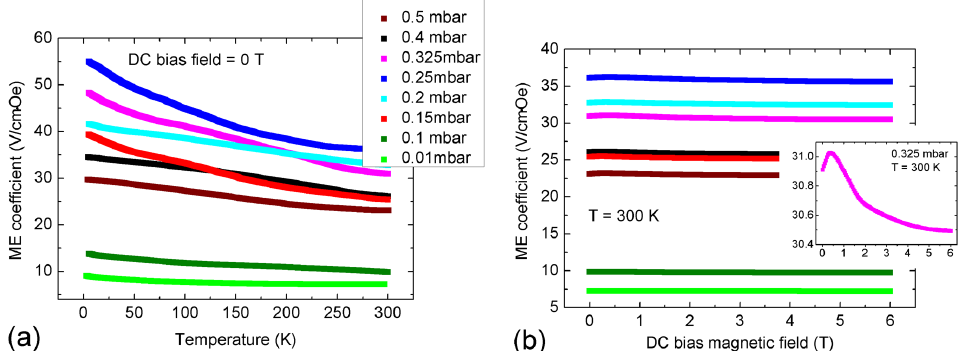
Figure 7. Magnetoelectric voltage coefficient α ME of BaTiO 3 ‐ BiFeO 3 composite thin films in dependence of ( a ) temperature and ( b ) the DC bias magnetic field, for the indicated oxygen partial pressures during the growth of the composites. The legend of ( a ) is valid for both ( a ) and ( b ). The DC bias dependence of α ME in ( b ) is generally weak with a local maximum around 0.5 T. The inset is an expanded view of α ME (H DC ) of the 0.325 mbar sample G5558c, compare Table 1. For additional field ‐ dependent α ME graphs, see the Supplementary Materials, Figure S12.